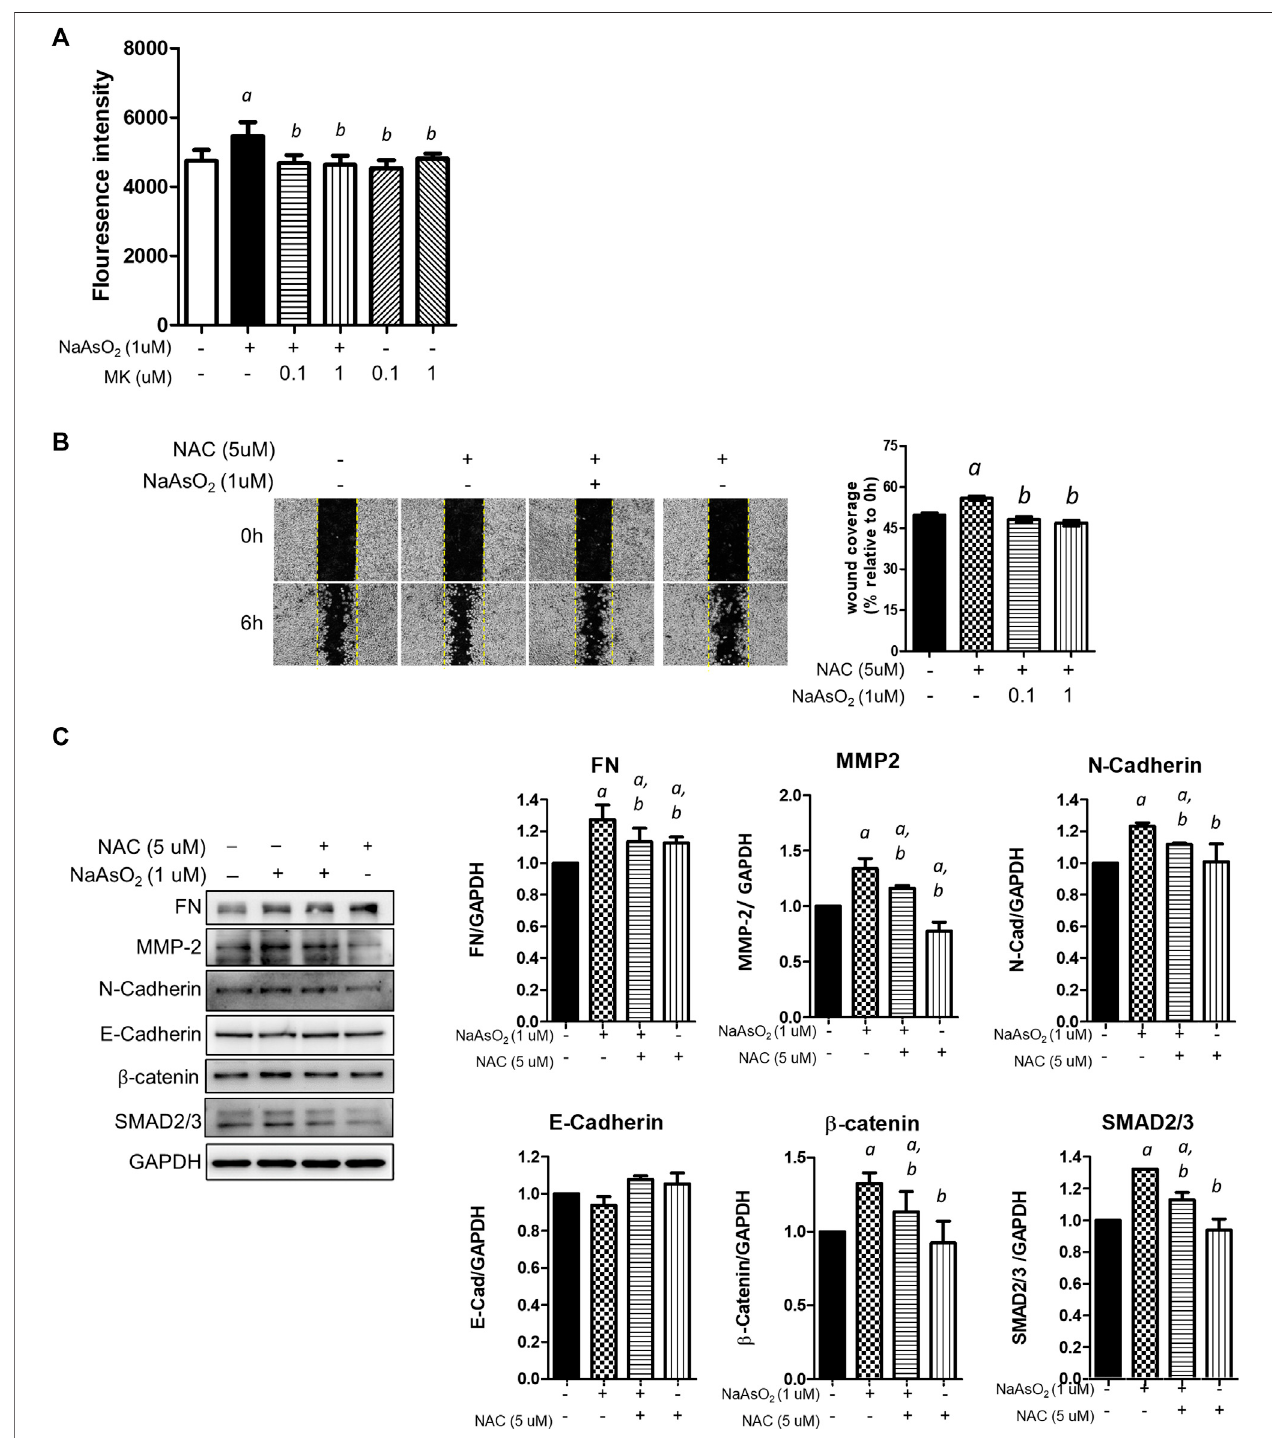
FIGURE 3 | The effects of montelukast on ROS generation and of the inhibition of ROS generation on arsenic-induced EMT of NHBE cells. (A) Cells seeded in 96- wellplateswerepretreatedwithmontelukastat0.1and1 µMfor2 h,andthen1 µMNaAsO 2 wasappliedforcombinationtreatment.After3 hoftreatment,thecellswere stained with 10 µM DCFH-DA for 30 min. After washing out the residue dye, the fl uorescent signal was measured immediately. The quantitative results (left panel) and representative images (right panel) are shown. a: p < 0.05 compared with the vehicle control group. b: p < 0.05 compared with the NaAsO2 group. (B) Cells were pretreated with NAC for 2 h, and then 1 µM NaAsO2 for another 24 h. Awound wasmade witha200-µltip, and the wound coverage wasanalyzed 6 h after the wound was made. a: p < 0.05 compared with the vehicle control group. b: p < 0.05 compared with the NaAsO2 group. (C) Cells were pretreated with NAC for 2 h, and then 1 µM NaAsO 2 was added for another 24 h. The cells were harvested for protein expression analysis by western blotting. a : p < 0.05 compared with the vehicle control group. b : p < 0.05 compared with the NaAsO 2 group.